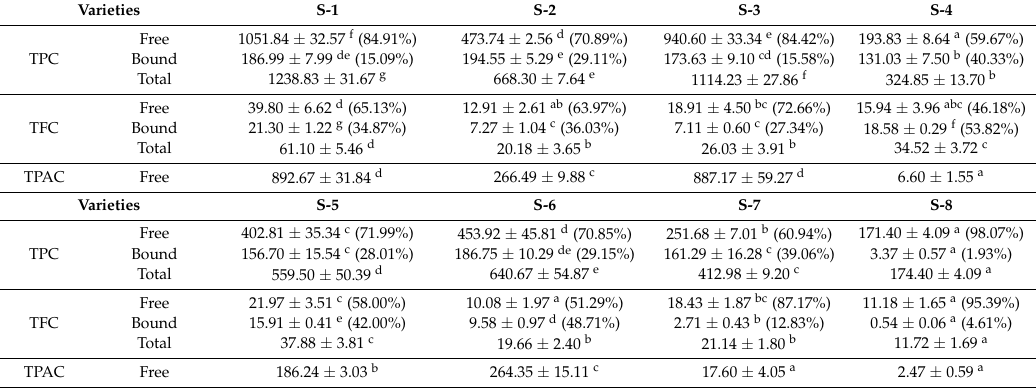
Table 2. TPC 1 (mg GAE 2 /100 g grain, DW 3 ) 4 , TFC 5 (mg RE 6 /100 g grain, DW) and TPAC 7